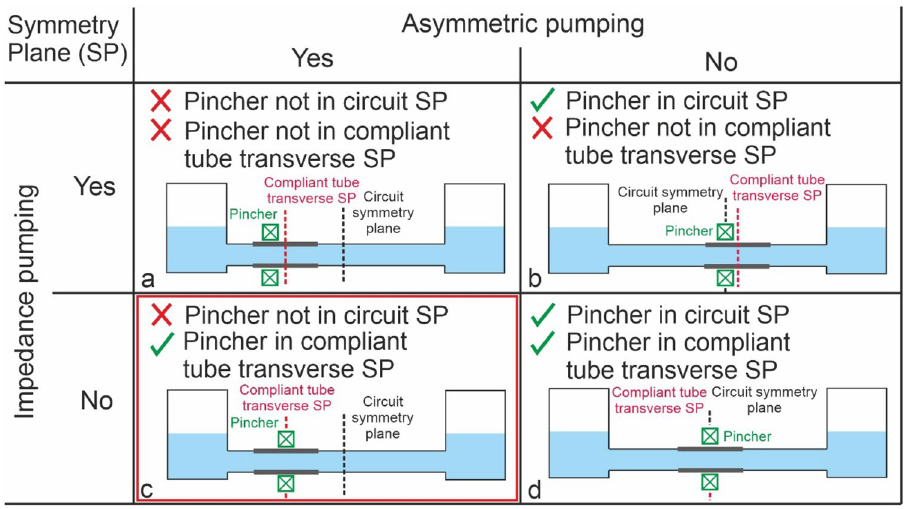
Figure 1. Impedance and asymmetric pumping illustrating asymmetry through length of compliant tubing. ( a ) Mixed (Liebau effect), ( b ) impedance, ( c ) asymmetric and ( d ) no pumping systems. SP = symmetry